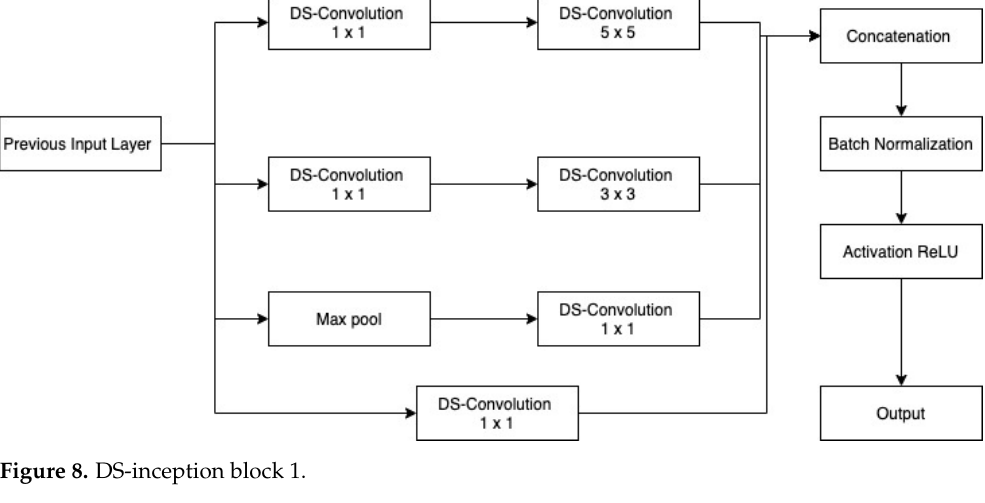
Figure 8. DS-inception block 1.